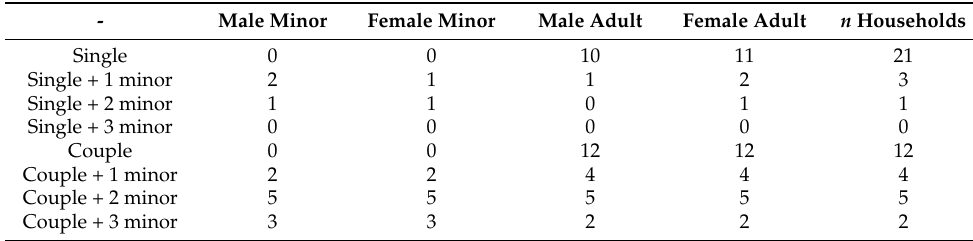
Table 3. Number of persons and households in the district under exam as assumed to match the Swedish data [45].